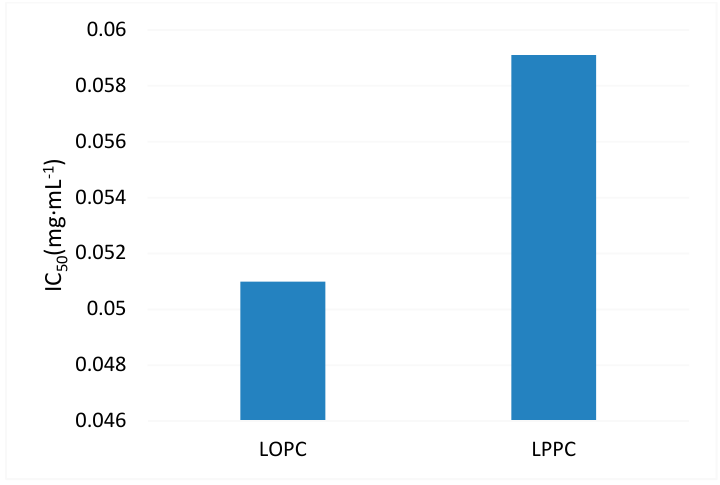
Figure 9. Half-maximal ABTS •+ free radical scavenging rate (IC 50 ) of LPPC and LOPC.